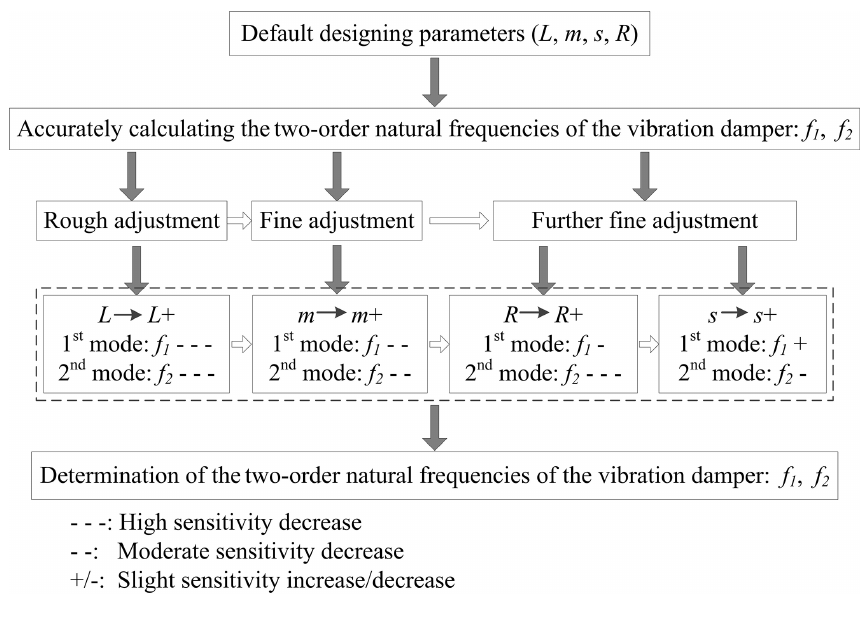
Figure 7. The sensitivity of a Stockbridge type vibration damper’s natural frequencies to the structural parameters, as well as the natural frequencies design process of a Stockbridge type vibration damper to obtain the target natural